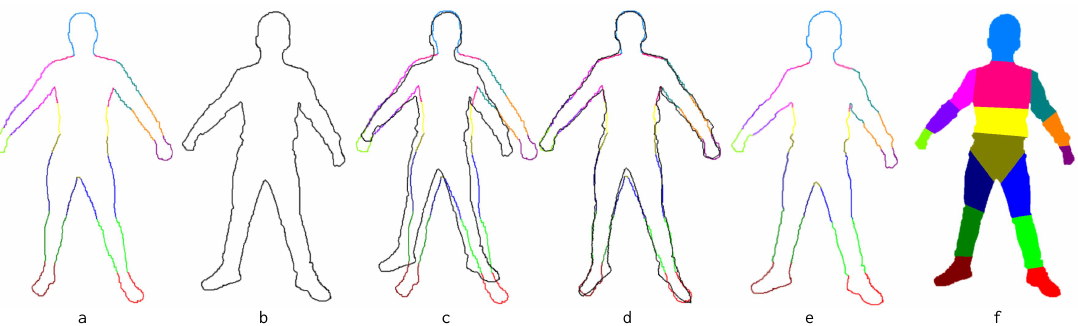
Figure 4. Stages in our kinematic classification. ( a ) The silhouette of our template projected to an image; ( b ) the silhouette of people in an image; ( c ) the result before alignment; ( d ) the aligned result after coherent point drift (CPD) [26]; ( e ) the classification of people’s silhouette obtained from our template; ( f ) the kinematic classification result. First, we extract the silhouettes from our template and people; then, we can classify the people’s silhouettes after aligning the silhouette in ( b ) to ( a ). Finally, we obtain the kinematic classifications ( f ) of the people in the images through a fully-connected conditional random field (CRF)